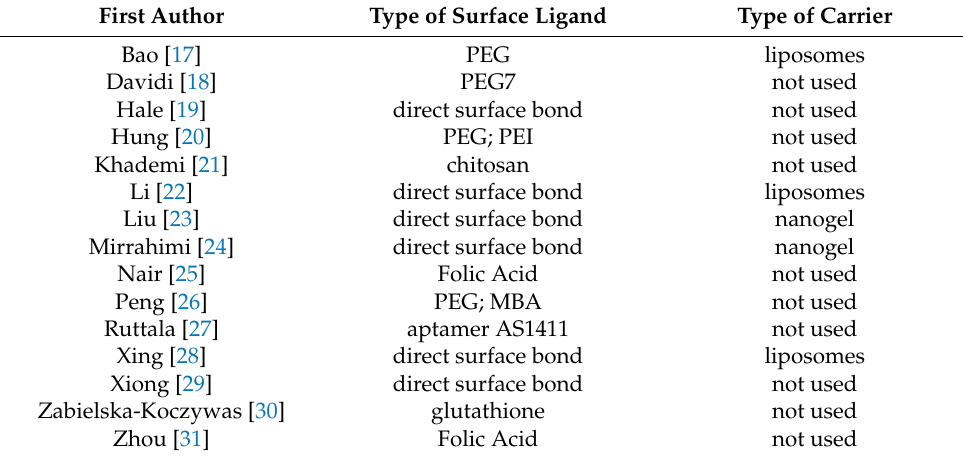
Table 3. Chemical synthesis of